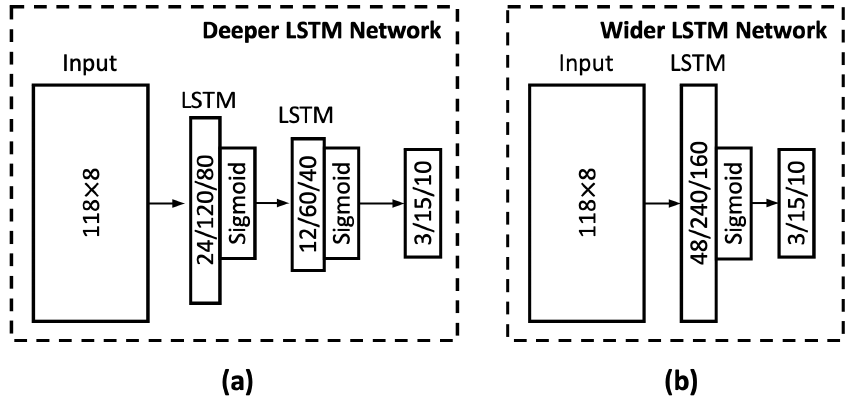
Figure A5. Proposed LSTM Network with increased ( a ) depth; ( b ) width. The three numbers in the LSTM layers and the output layer correspond to proposed LSTM model for northern, interior, and western Delta groups, respectively. Table A9. Total numbers of parameters in the deeper and wider MLP model (ungrouped) and LSTM network (grouped) tested in the study. MLP, LSTM, Grouped Ver.